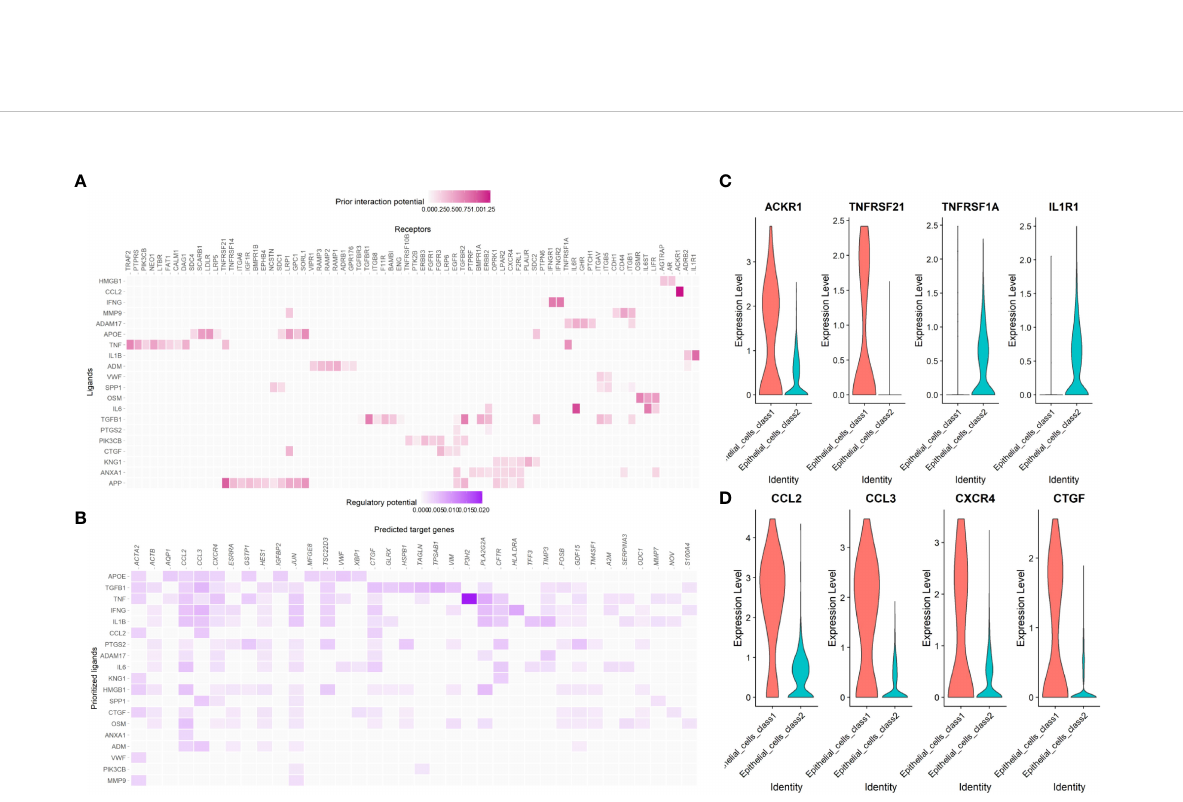
FIGURE 14 The cell-cell interaction between malignant epithelial cells and other cells. (A) The regulatory potential of the prioritized cell ligard-receptor pairs in the development of maligant epithelial cells. (B) The regulatory potential of the prioritized cell ligard-target pairs in the development of maligant epithelial cells. (C) The expression of the prioritized receptors in the development of maligant epithelial cells. (D) The expression of the prioritized targets in the development of maligant epithelial